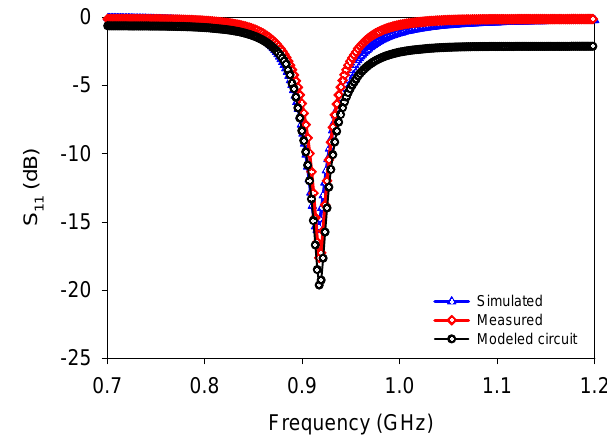
Figure 6: Reflection coefficient of S 11 calculated from the simulated, the equivalent circuit model, and the measured